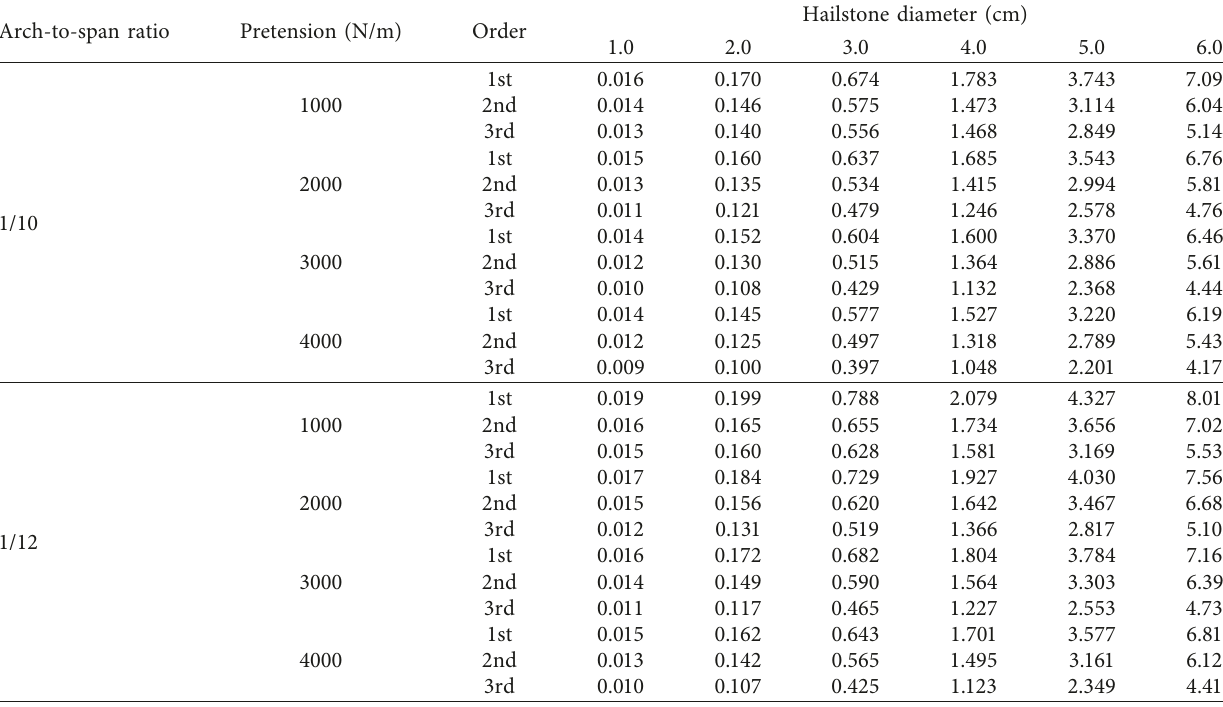
Table 2: First three-order max. amplitude values (mm) of the impact point. Arch-to-span ratio